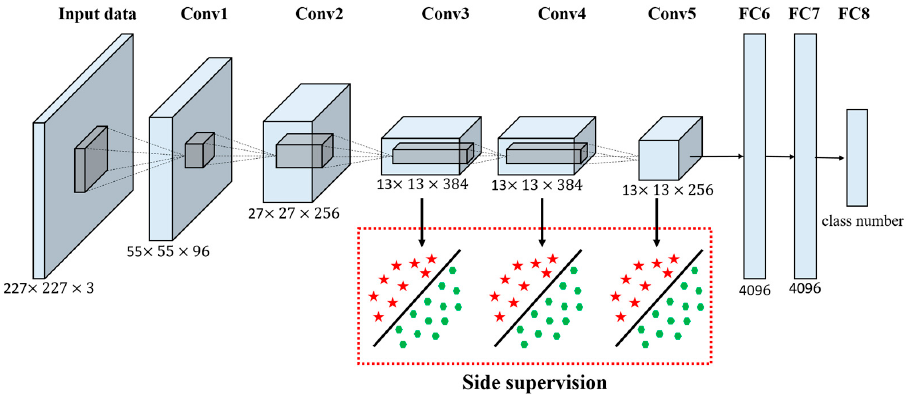
Figure 3. The AlexNet architecture with side supervision.